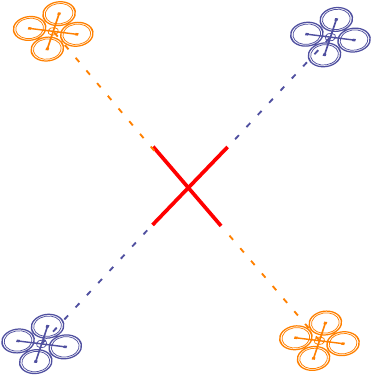
Figure 5. Collision danger zone between two